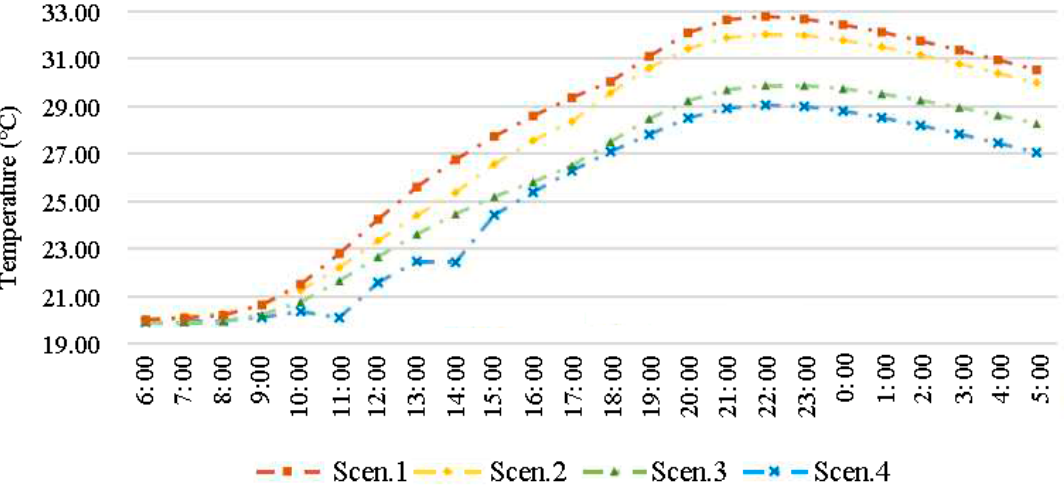
Figure 13. Inside wall surface temperature of the four scenarios in a day.